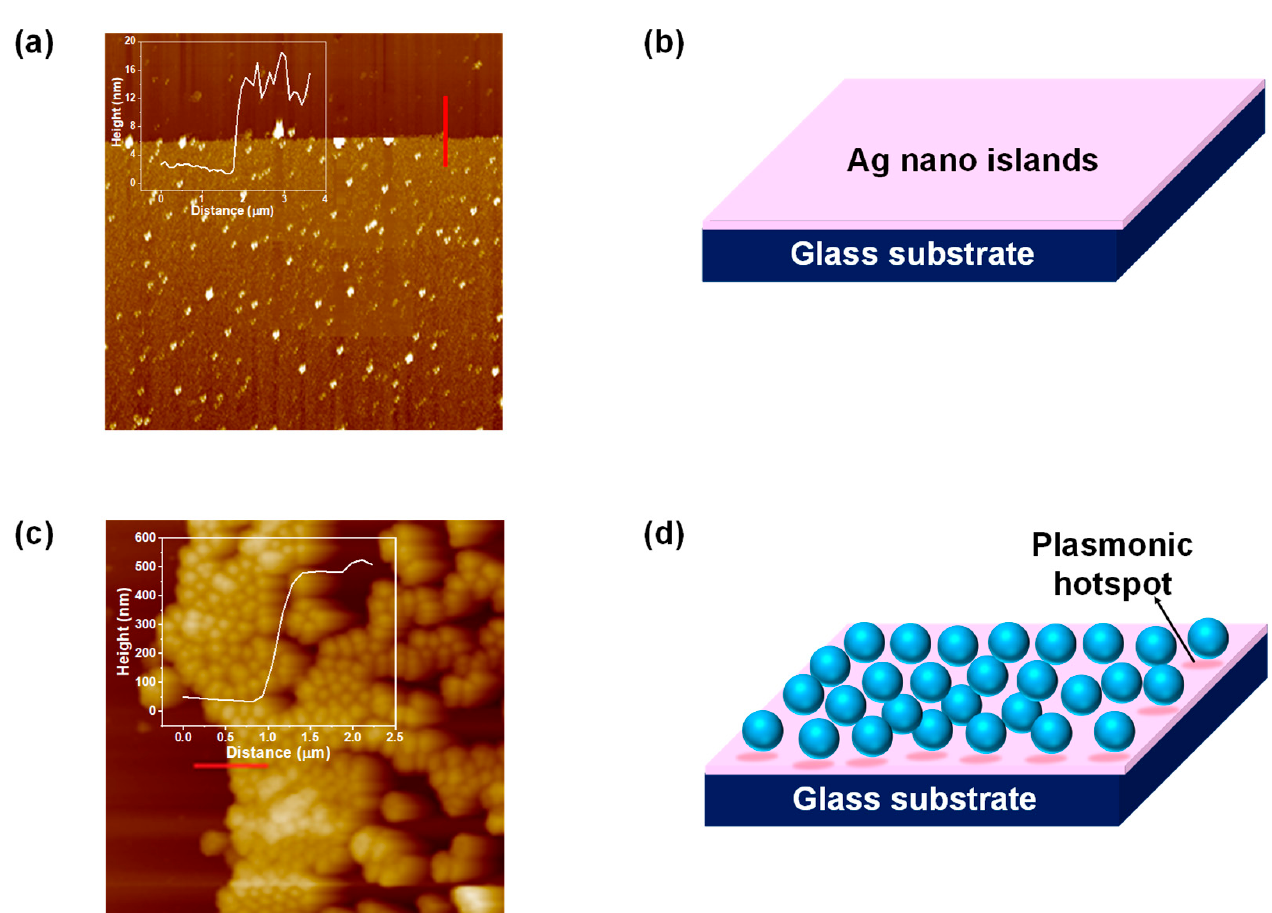
Figure 3. ( a ) 2D topography of silver nano-islands deposited over glass coverslip and the height profile (inset) along the red line of the surface; ( b ) schematic representation of silver nano-islands deposited over glass coverslip; ( c ) 2D topography of silica nanospheres-decorated silver nano-is- lands deposited over glass coverslip and the height profile (inset) along the red line of the surface; ( d ) schematic representation of silica nanospheres-decorated silver nano-islands deposited over glass coverslip.